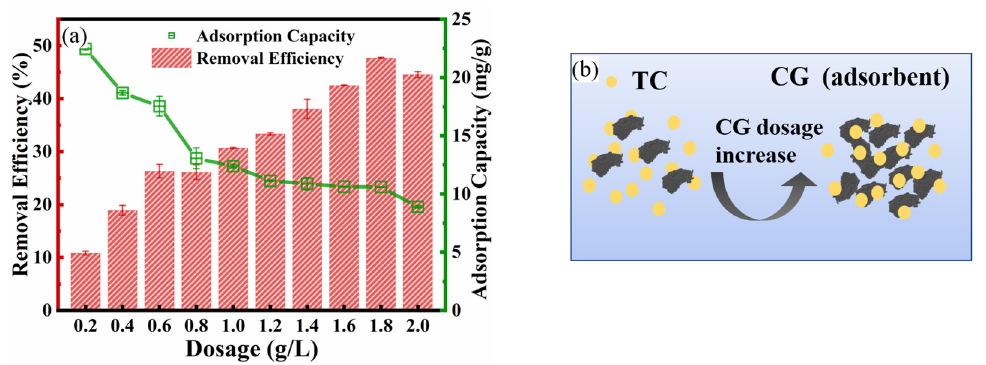
Figure 4 . Effect of adsorbent dosage for TC adsorption: ( a ) Effect of CG dosage on removal efficiency and adsorption capacity of TC by CG (contact time of 3 h, TC concentration of 40 mg/L, pH of 6.2 and temperature of 25 °C, 120 rpm); ( b ) the proposed schematic diagram of TC adsorption by CG with increasing CG dosage.